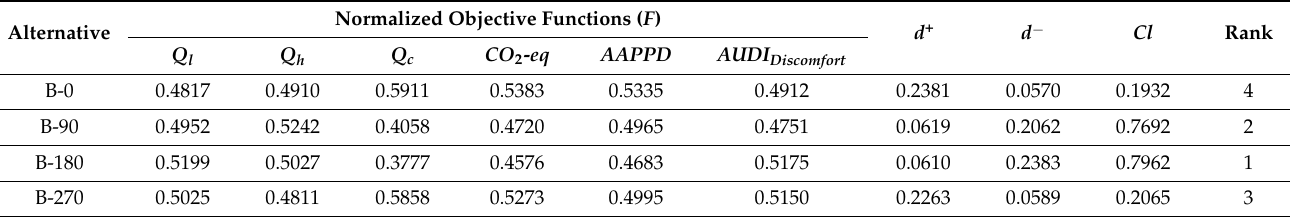
Table 5. The TOPSIS results for different orientations of the building type